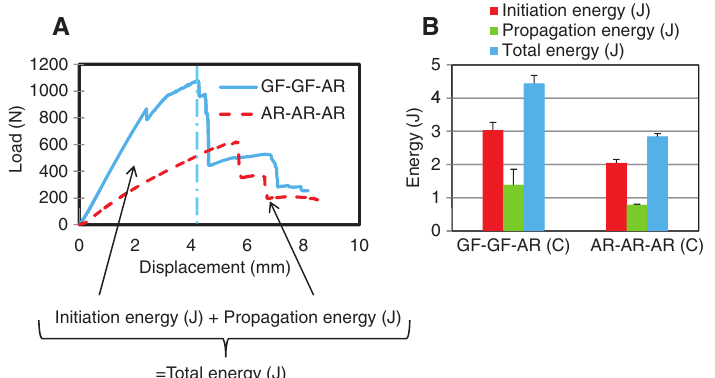
Figure 3 (A) Load-displacement curves of BWK composites during the three-point bending test and (B) energy results from the three-point bending